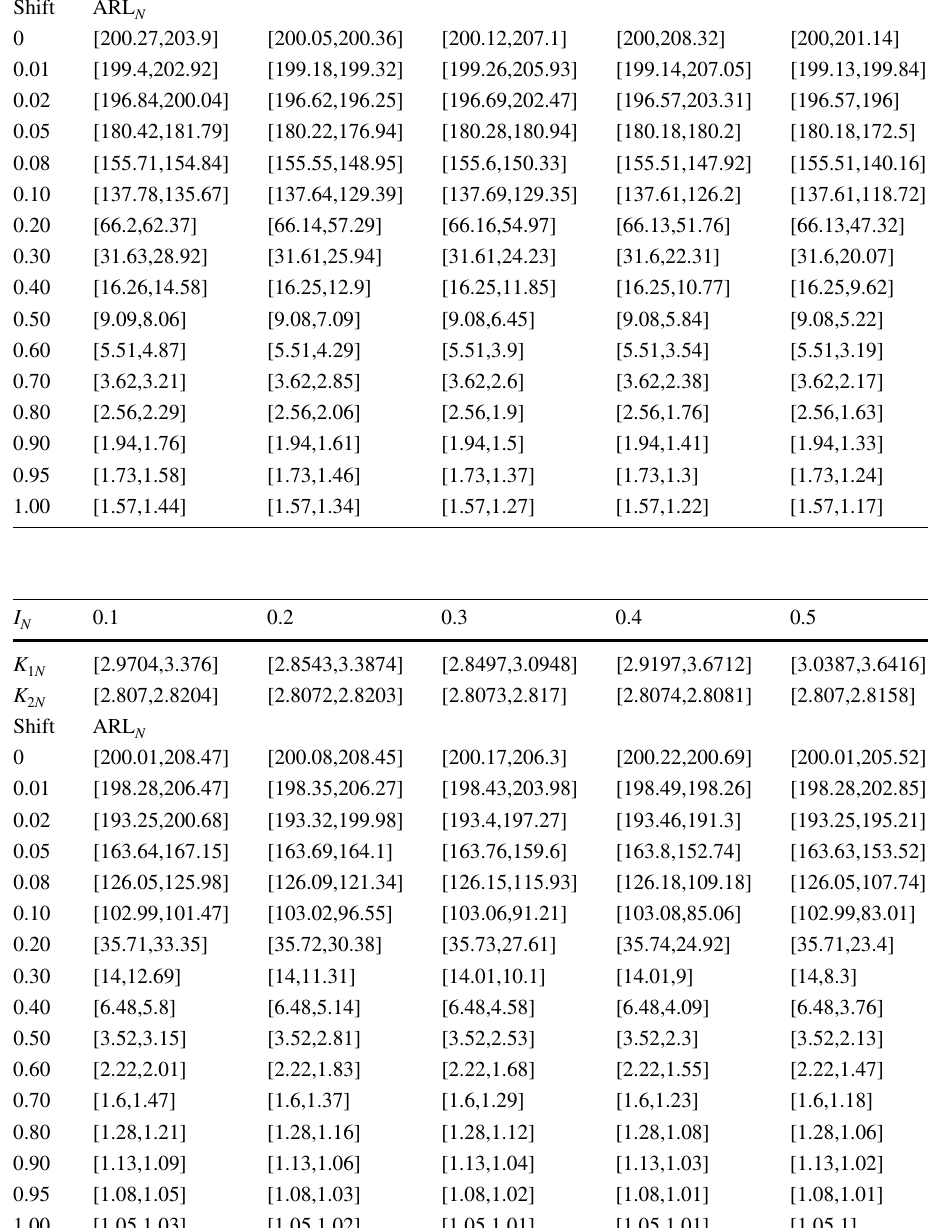
Table 2 The average run length ARL 1 values under neutrosophic statistics for n L = 10